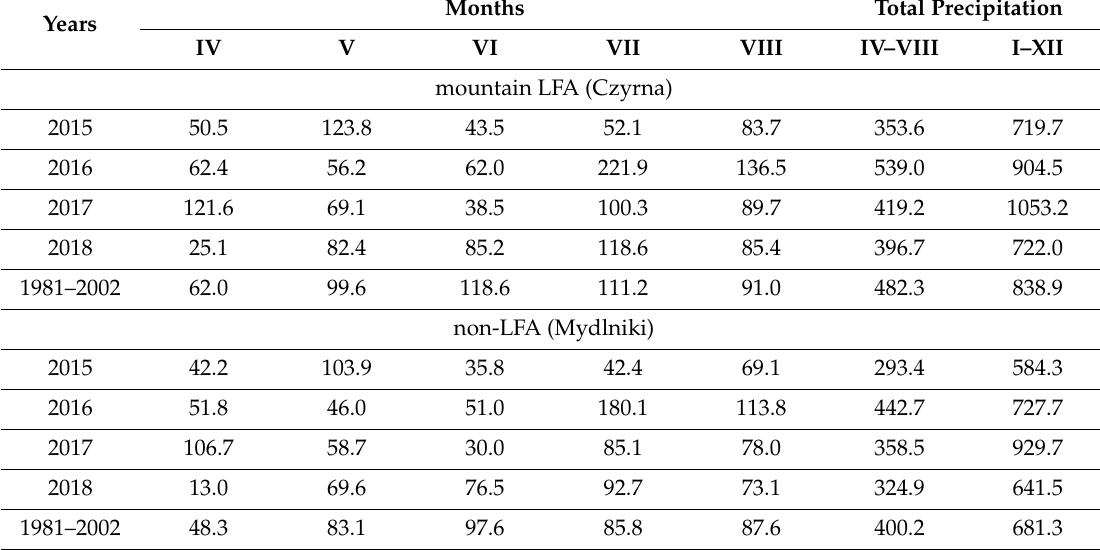
Table 1. Monthly precipitation distribution (mm) during the vegetation period in the years 2015–2018 in Czyrna (mountain Less Favoured Area—mountain LFA) and Mydlniki